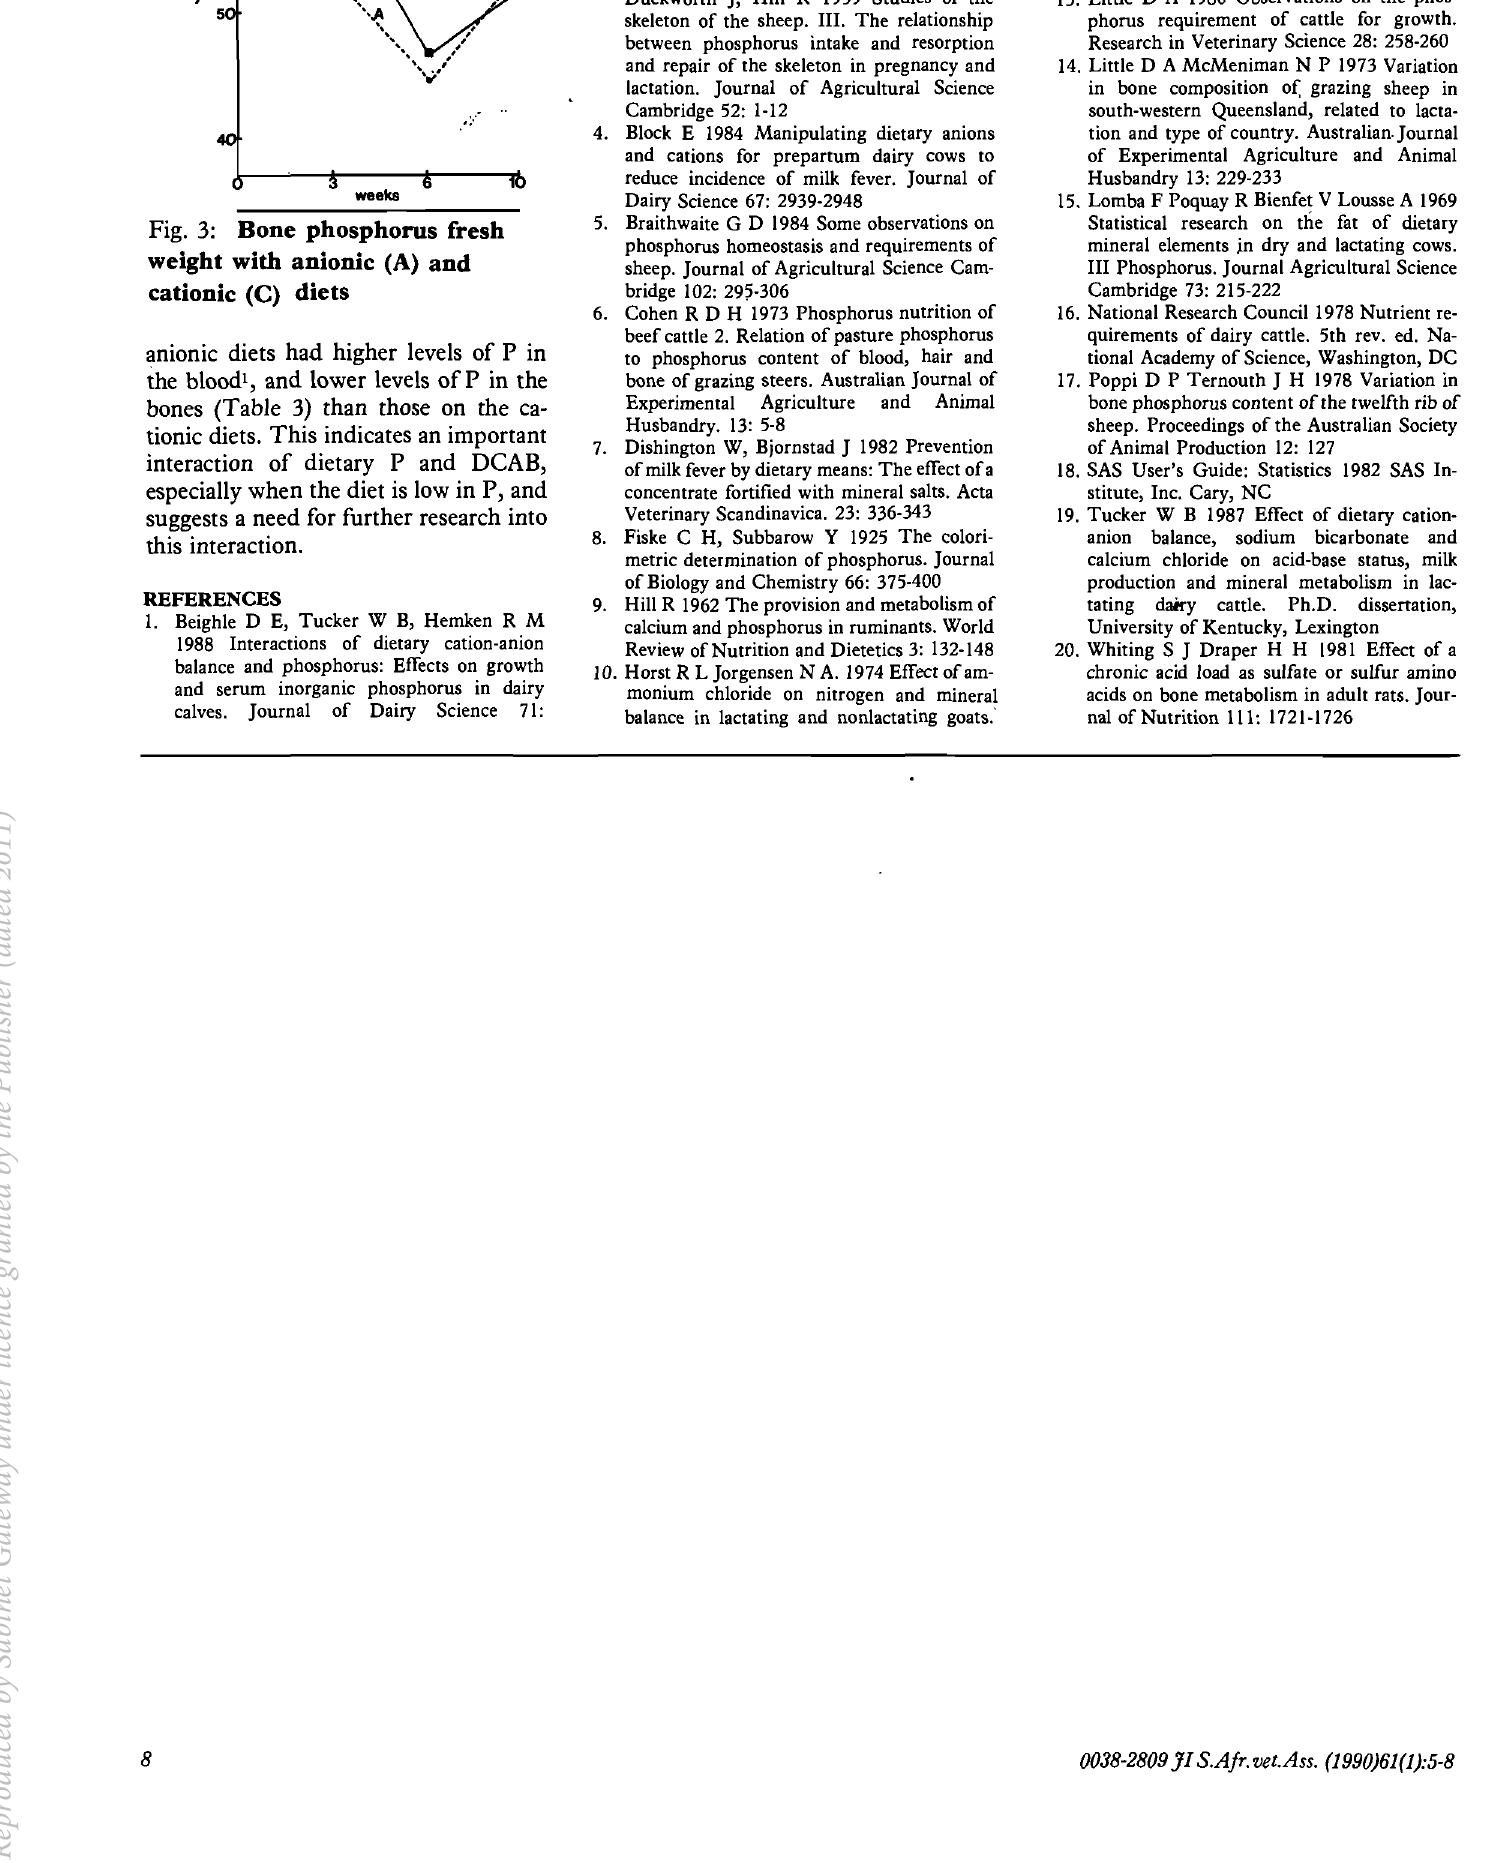
Fig. 3: Bone phosphorus fresh weight with anionic (A) and cationic (C) diets anionic diets had higher levels of P in the blood l , and lower levels ofP in the bones (Table 3) than those on the ca tionic diets. This indicates an important interaction of dietary P and DeAB, especially when the diet is low in P, and suggests a need for further research into this interaction.